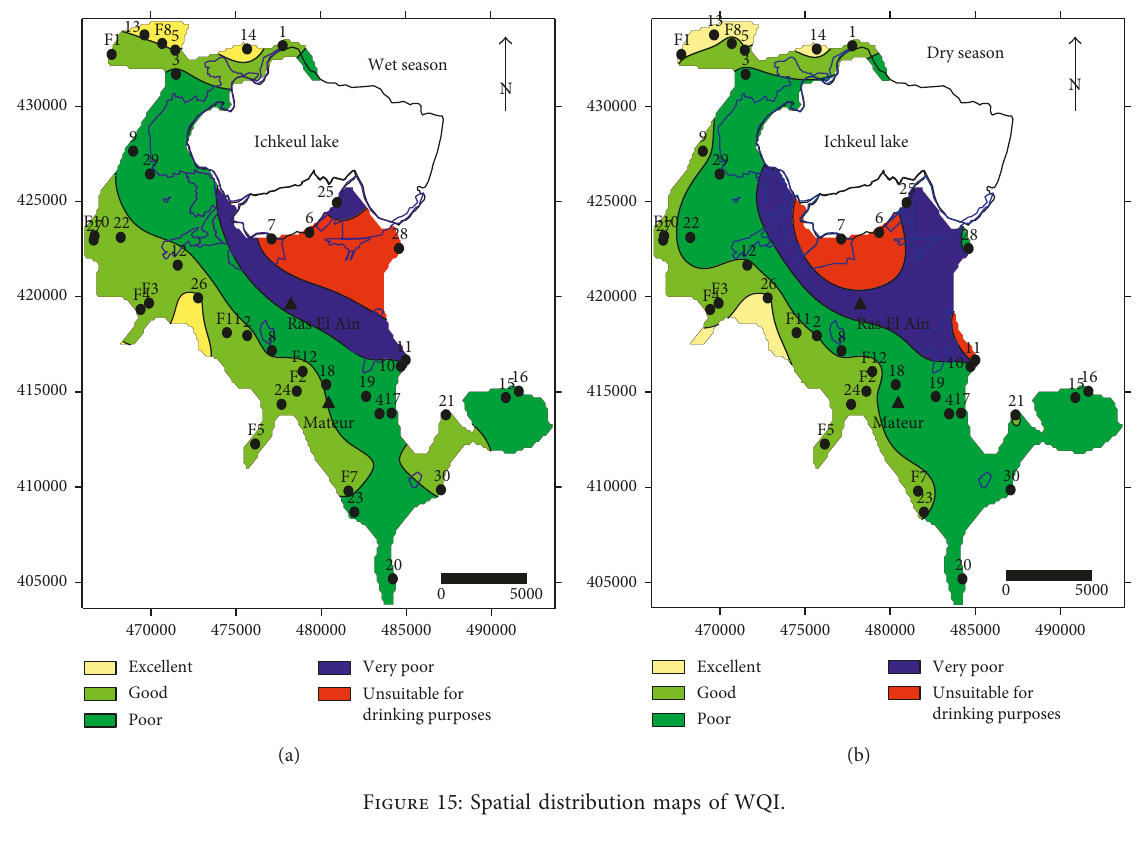
Figure 15: Spatial distribution maps of